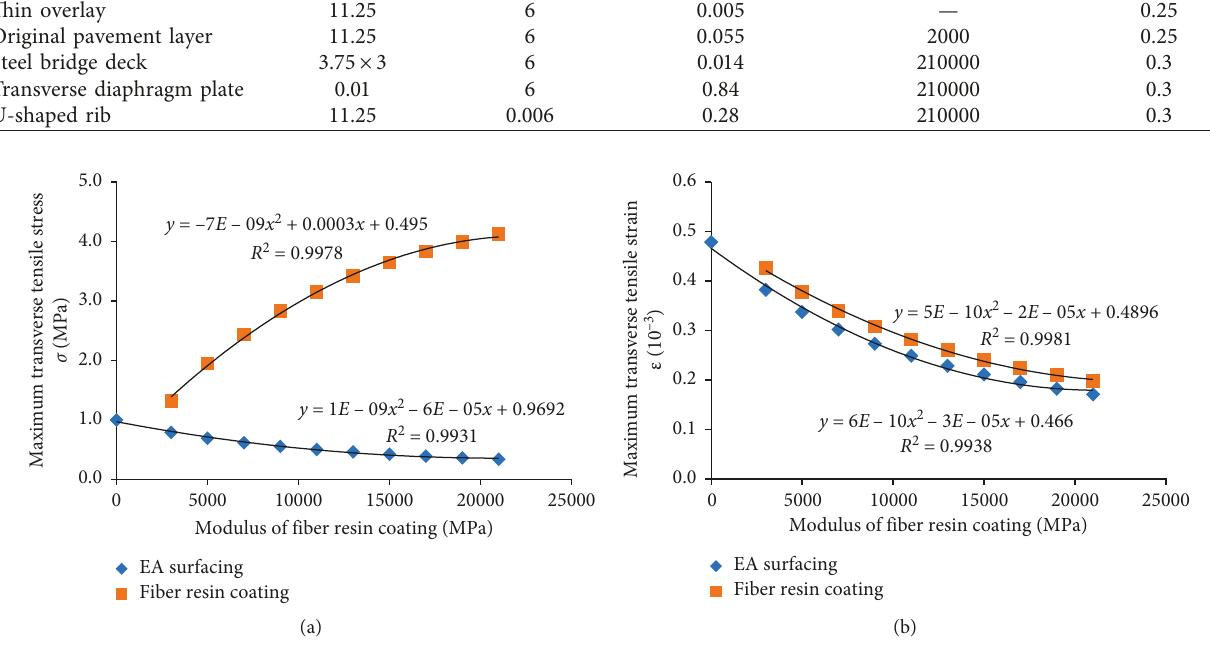
Figure 4: Change laws of the maximum tensile stress and strain of the pavement layer with modulus of the thin overlay.